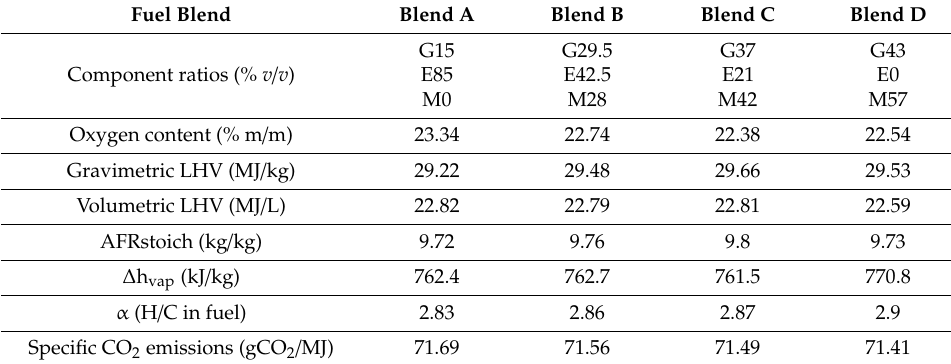
Table 5. Properties of the GEM blends tested on the 4-cylinder 1.8 L PFI production engine.